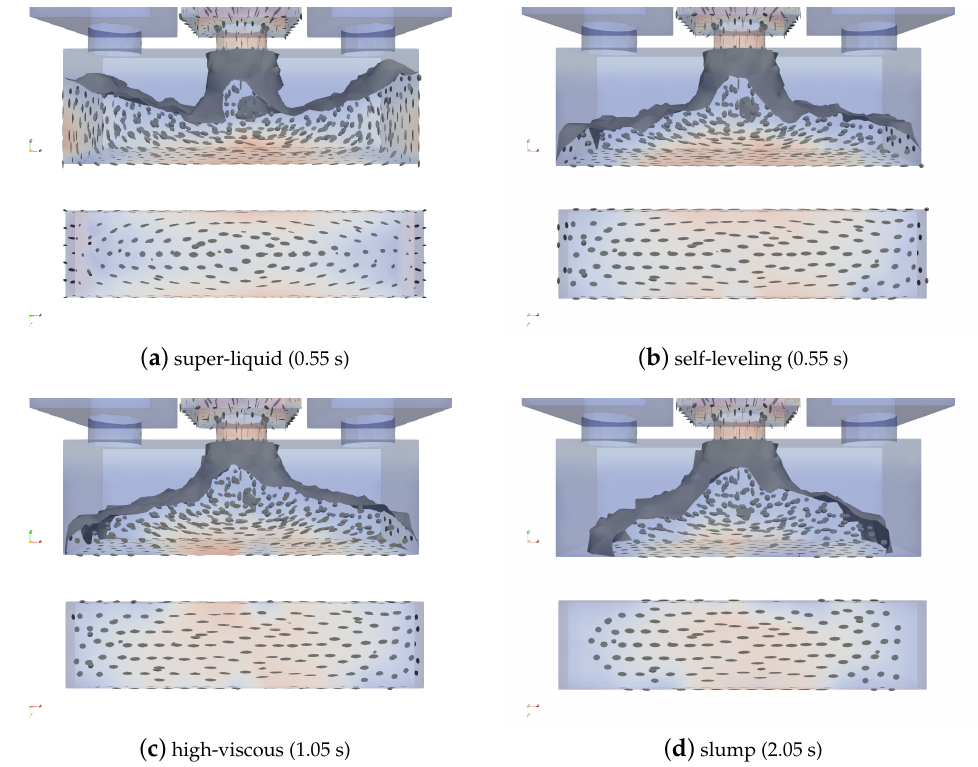
Figure 4. Comparison of the flow behavior, to give an impression of the viscosity (workability, flowability) of the simulated concrete mass. Shown are intermediate time